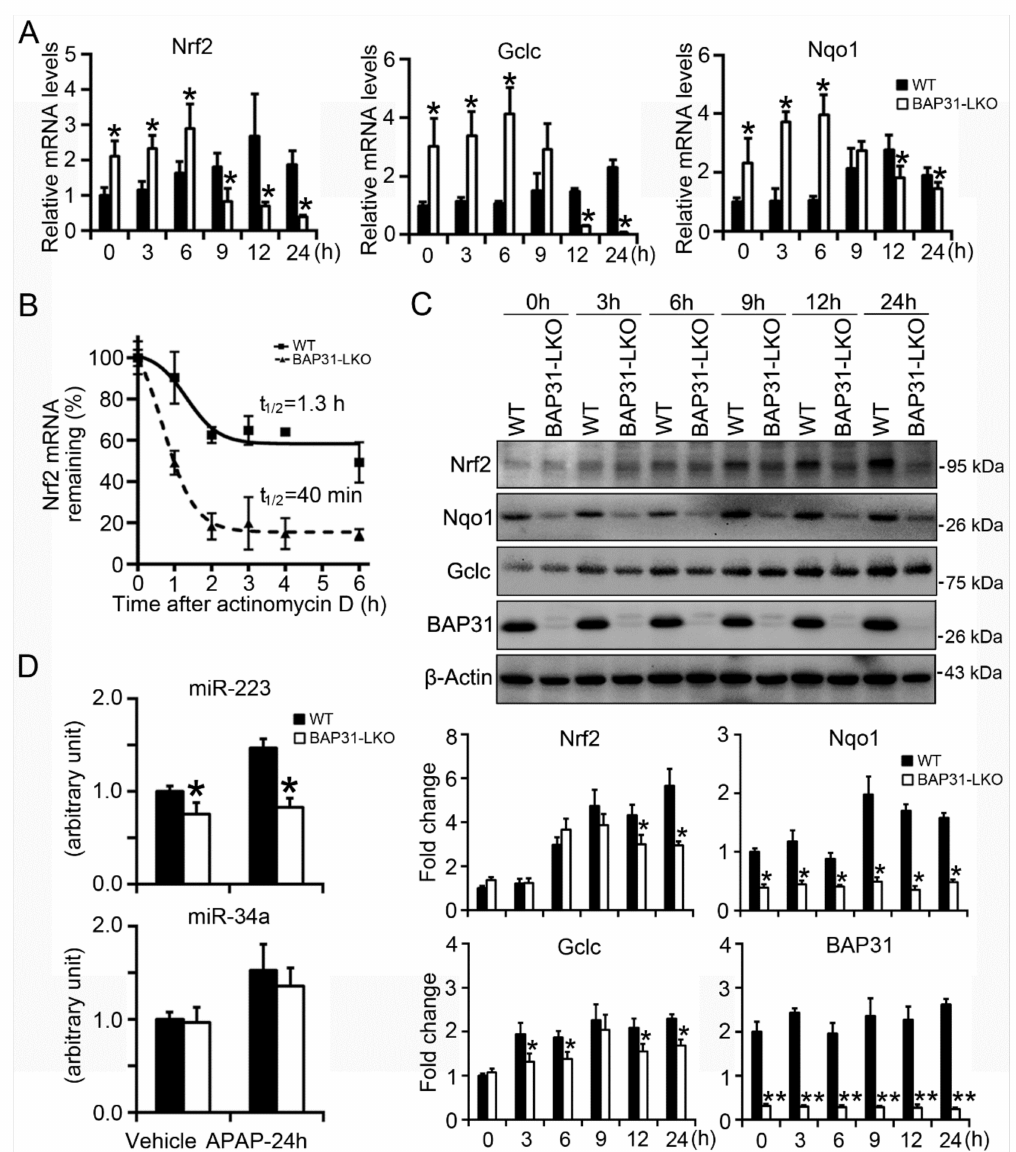
Figure 6. BAP31-deficiency reduced mRNA stability and impaired Nrf2 signaling induction. ( A ) Primary mouse hepatocytes were isolated from WT and BAP31-LKO mice and then were treated with APAP (5 mM) for 0, 3, 6, 9, 12, and 24 h. The mRNA levels of Nrf2 , Nqo1 , and Gclc were determined. ( B ) BAP31-deficiency reduced Nrf2 mRNA stability. Actinomycin D was added to the culture medium for the indicated time. Nrf2 mRNA levels were determined, and the half-life was calculated to assess mRNA decay kinetics. ( C ) Cellular protein was extracted from the primary hepatocytes, and the protein levels of Nrf2, Nqo1, Gclc, and BAP31 were determined. β -Actin was used as the loading control. *, p < 0.05, **, p < 0.01, BAP31-LKO hepatocytes compared to WT hepatocytes. ( D ) The expression levels of miR-223 and miR-34a were determined in liver tissues. U6 was selected as the internal control. n = 5 per group. Data are expressed as mean ± SE. *, p < 0.05, BAP31-LKO compared to WT